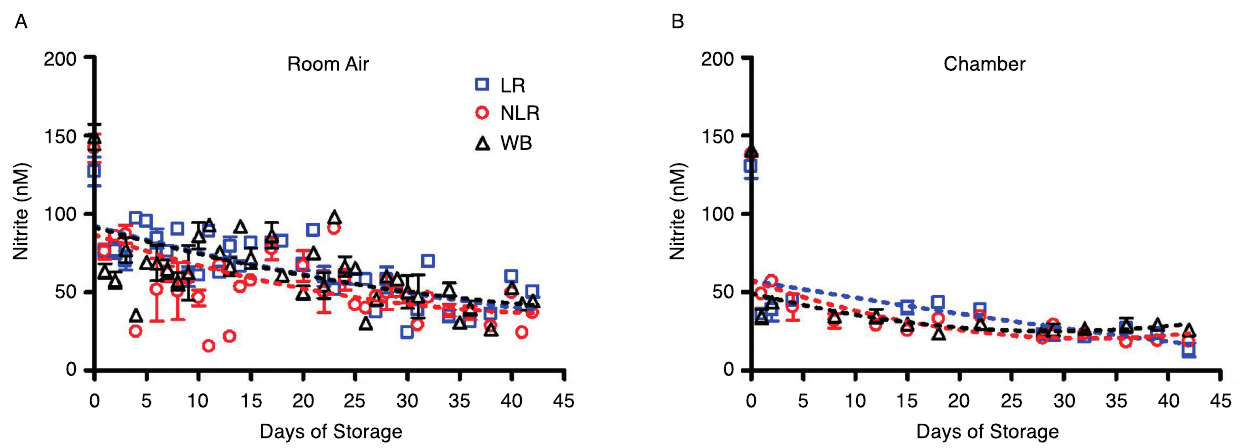
Figure 2. Time-dependent changes in nitrite concentration during storage. Blood components stored in the three forms noted were kept for 42 days at 4°C in either room air ( 2A ) or an argon chamber ( 2B ), to emulate aerobic and hypoxic conditions, respectively; number of donors, n=3 ( A ), n=3 ( B